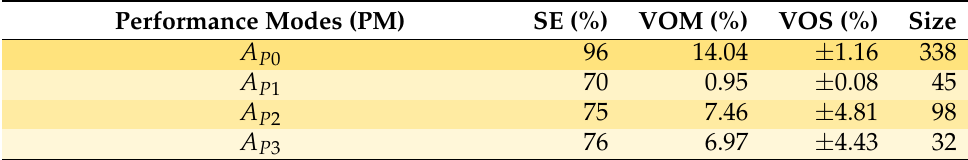
Table 4. Performance modes identified after receiving chunk 2.